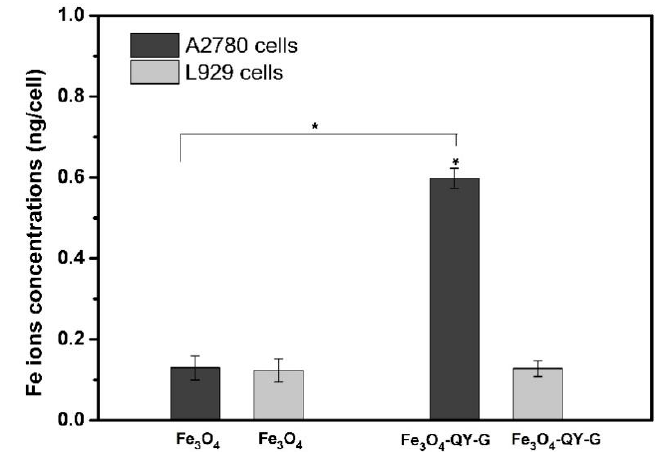
Figure 9. The Fe ion concentration in each A2780 and L929 cell after co ‐ cultured with Fe 3 O 4 ‐ QY ‐ G and Fe 3 O 4 nanoparticles for 24 h at a concentration of 100 μ g/mL in the medium, * shows significant differences between the corresponding groups, * p < differences between the corresponding groups, * p < 0.05.